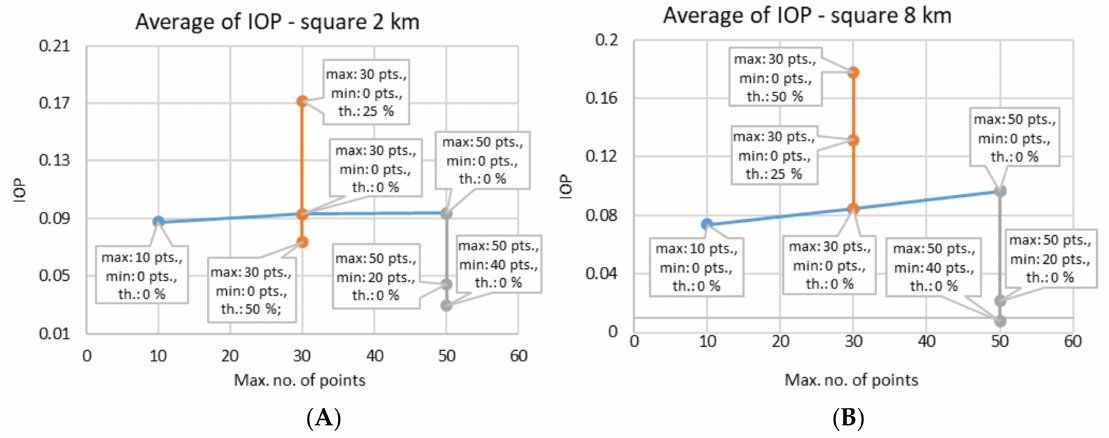
Figure 12. Diagrams of the average value of the index of passability for squares: ( A )—2 × 2 km, ( B )—8 × 8